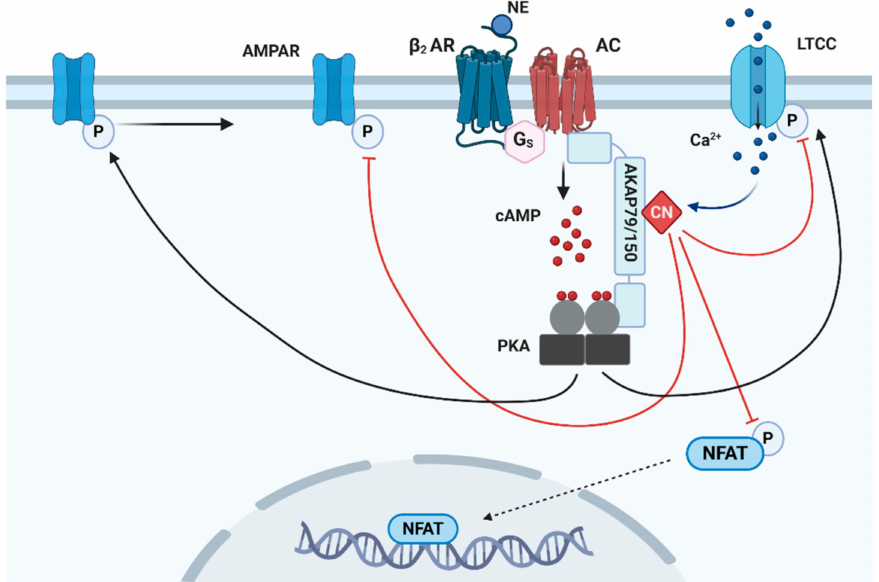
Figure 3. AKAP79/150 is involved in the coordination of synaptic plasticity. At the PSD, AKAP79/150 assembles a multiproteic complex containing β 2 -ARs, AMPARs, PKA, CaN and an adenylyl cyclase (likely AC5). This complex is involved in NMDAR-independent LTP, where stimu- lation of β 2 -ARs (by norepinephrine, NE) results in increased PKA dependent phosphorylation of AMPAR GluR1 and of CaV 1.2 LTCCs. PKA phosphorylation promotes exocytosis, lateral diffusion and synaptic accumulation of AMPARs, and increases the opening probability of both AMPAR and LTCCs. Activation of CaN by Ca 2+ influx through LTCC counteracts phosphorylation of both LTCC, as a negative feedback regulation to hinder Ca 2+ entry, and AMPAR. Dephosphorylated AMPAR are removed from the synapse (not shown), leading to LTD. Moreover, activation of CaN leads to the dephosphorylation of NFAT, promoting its translocation in the nucleus, where it can act as transcriptional activator/repressor. Persistent CaN activation leads to down-regulation of NFAT targets including synaptic genes, resembling the transcriptional profiles encountered in human AD brain. A similar complex assembled by AKAP79/150 close to NMDAR (not shown) mediates LTP and contains AMPAR, PKA, CN and a Ca 2+ -activated AC (likely AC1 or AC8). Created with